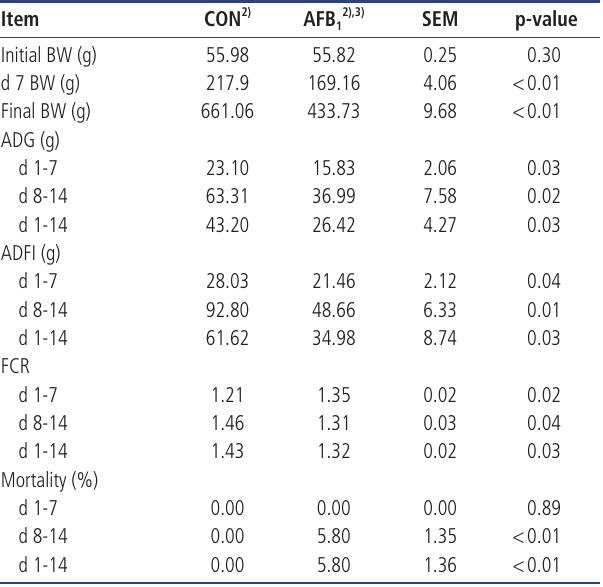
Table 5. Effects of feeding corn naturally contaminated with AFB performance in ducklings 1)